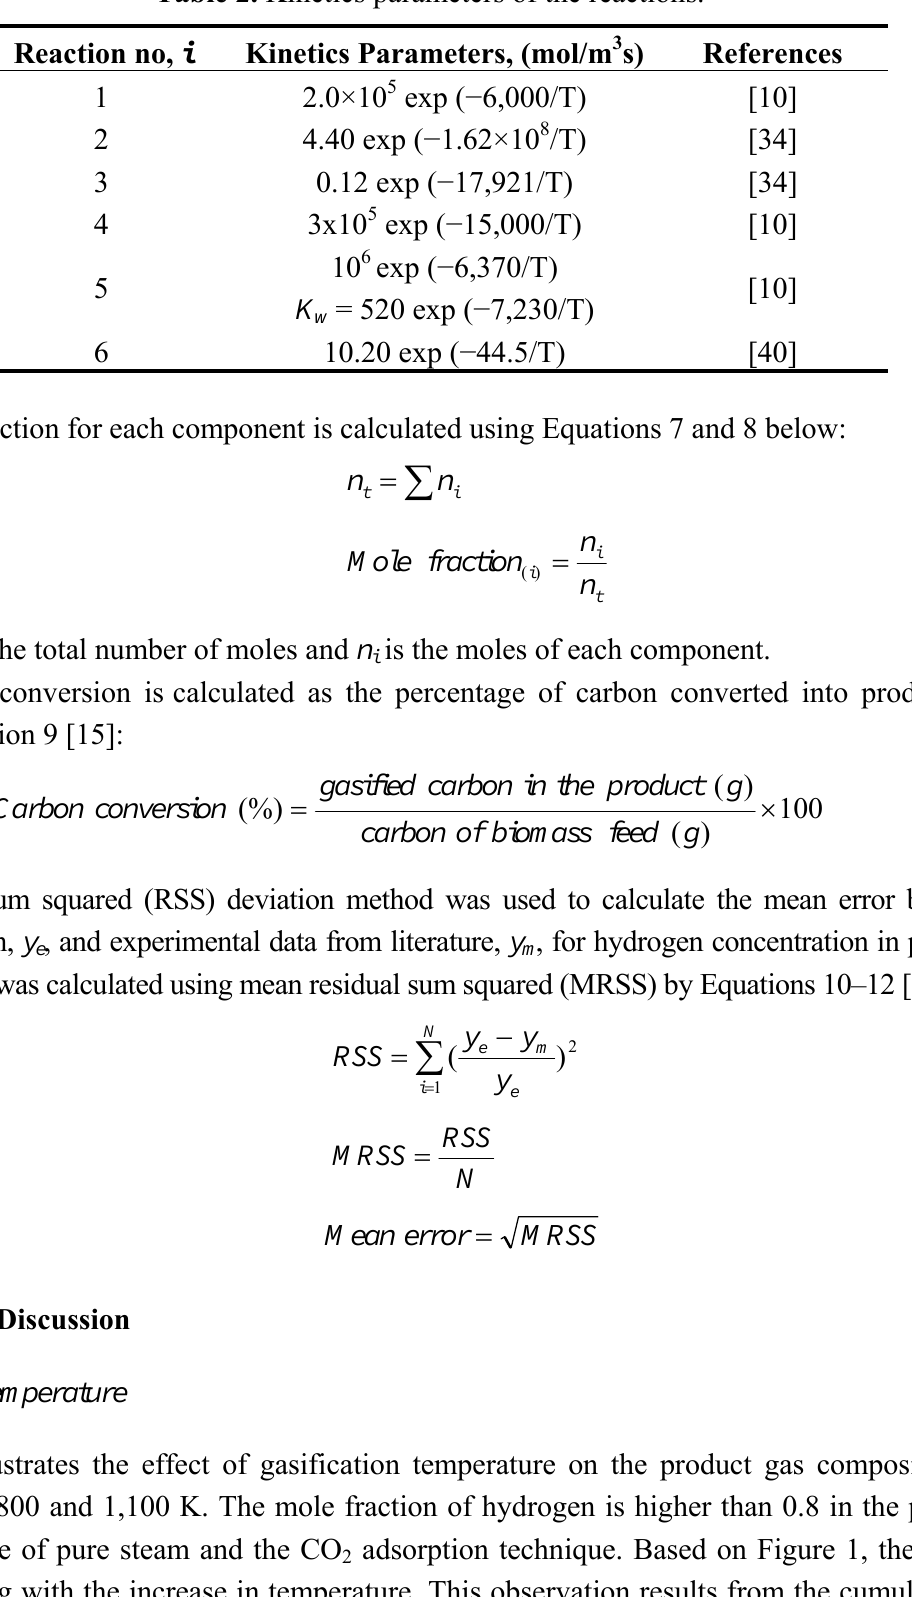
Table 2. Kinetics parameters of the